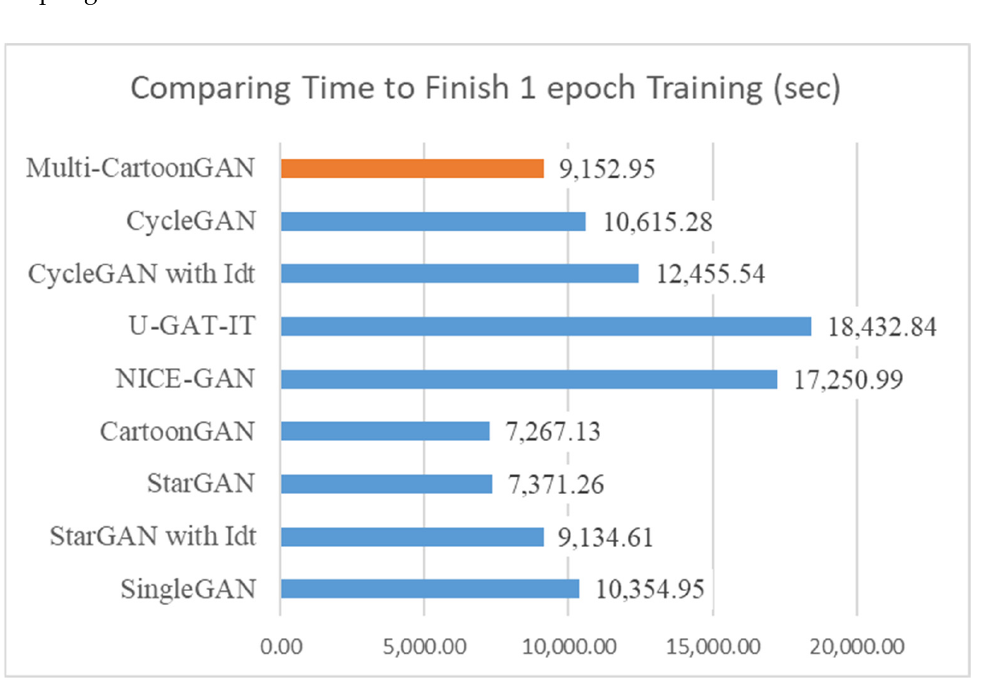
Figure 6. Comparing the GPU computational cost (Idt refers to the model learned identity mapping for preventing extreme color tinting).